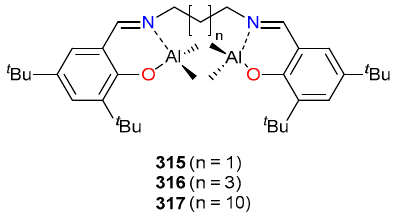
Figure 47. Bimetallic Al-complexes active in the ROP of lactones, epoxides and anhydrides [132,133].